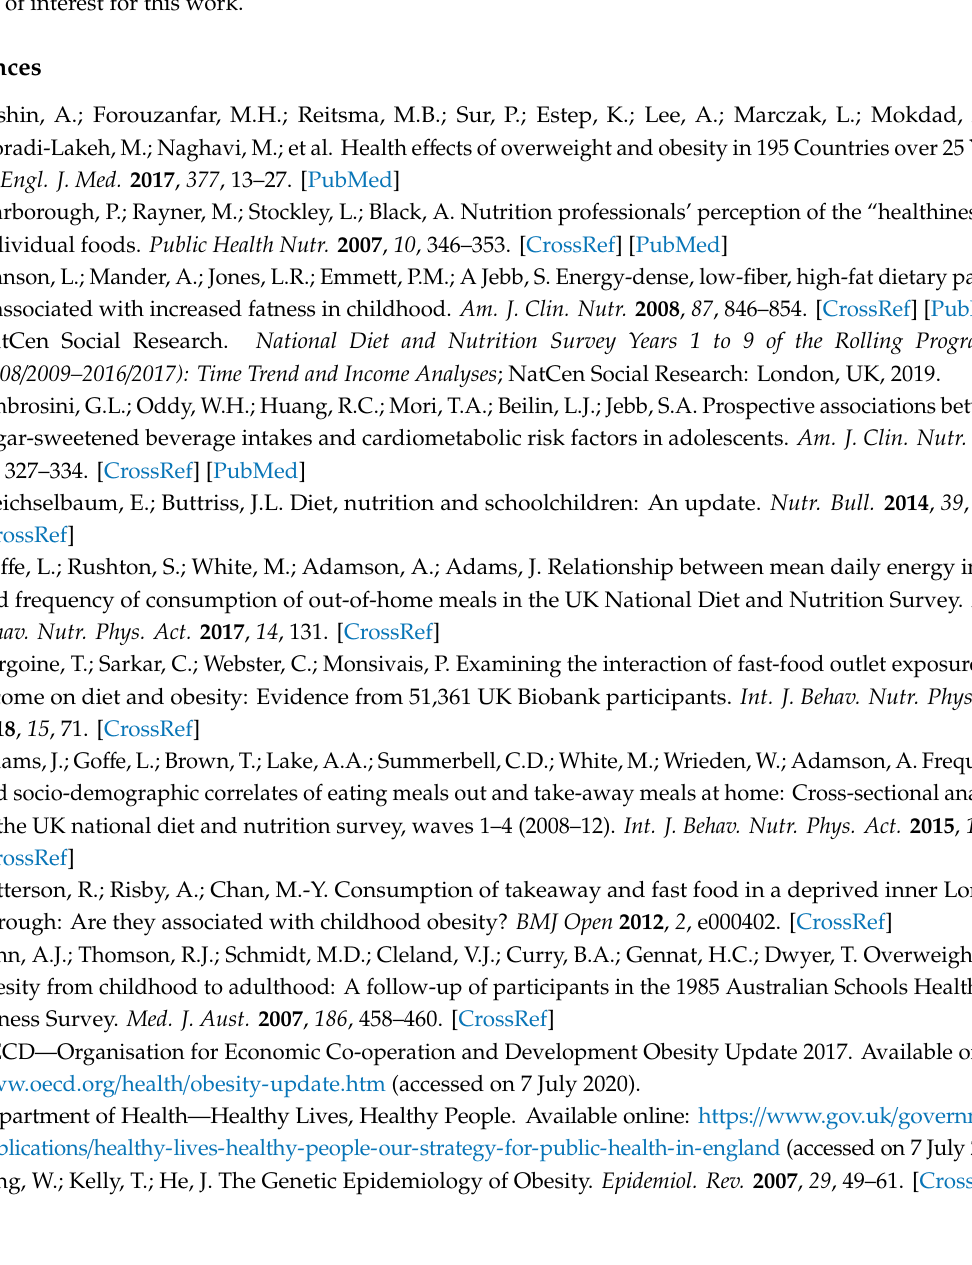
with Individual NDNS Weights. Figure S9: Correspondence Analysis Plot for Less-Healthy Foods, with Adjusted NDNS Weights. Figure S10: Correspondence Analysis Including All 25 Main (P80) Food Groups for the 2008–2012 Survey